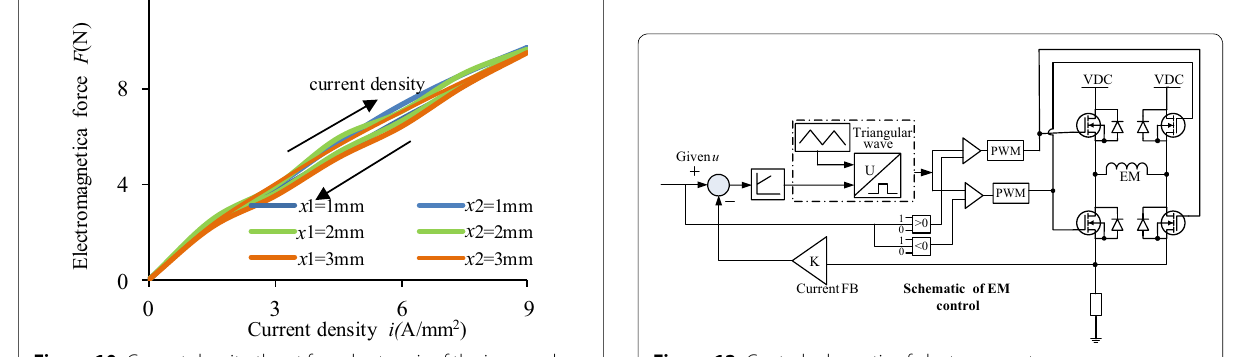
Figure 10 Current density-thrust force hysteresis of the inner rod